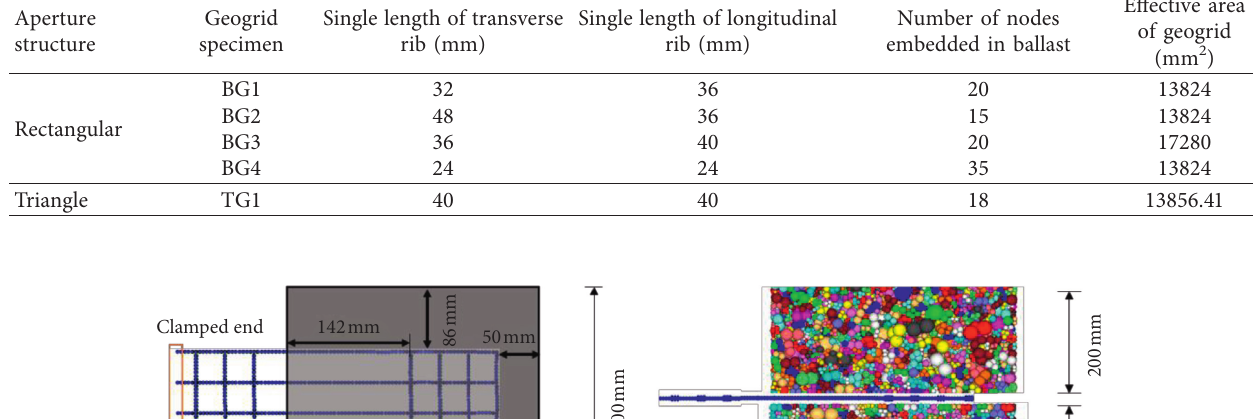
Table 2: Geometry and detail structure dimensions of geogrid specimens in DEM.